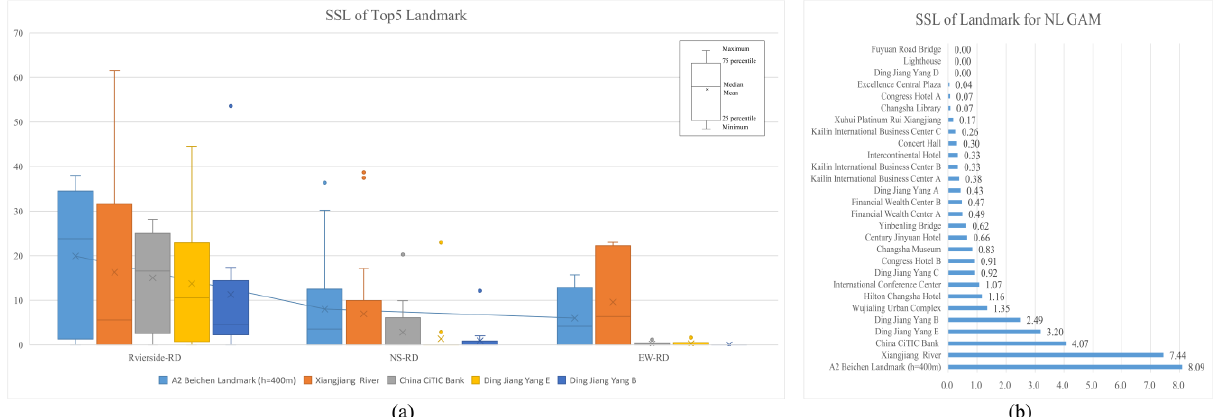
Figure 19. Structural salience of XD-district landmarks (H a2 = 400 m). ( a ) Boxplot of the structural salience of the Top 5 landmarks corresponding to each decision point, ( b ) bar chart of the structural salience of landmarks in grid.